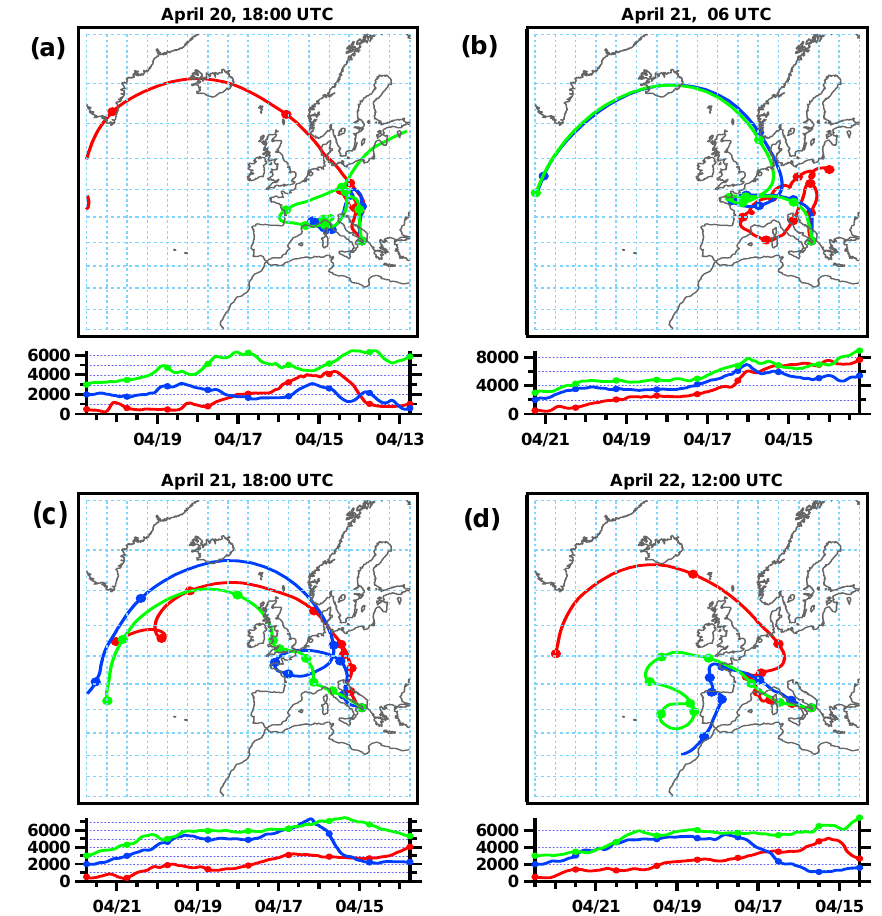
Fig. 1. 8-day back trajectories from the Hybrid Single Particle Lagrangian Integrated Trajectory Model (HYSPLIT) of air masses ending at the Physics Department of the Salento University, Lecce (Italy), (a) on 20 April at 18:00UTC, (b) on 21 April at 06:00UTC, (c) on 21 April at 18:00UTC, and (d) on 22 April at Figure 1 (M. R. Perrone et al.)